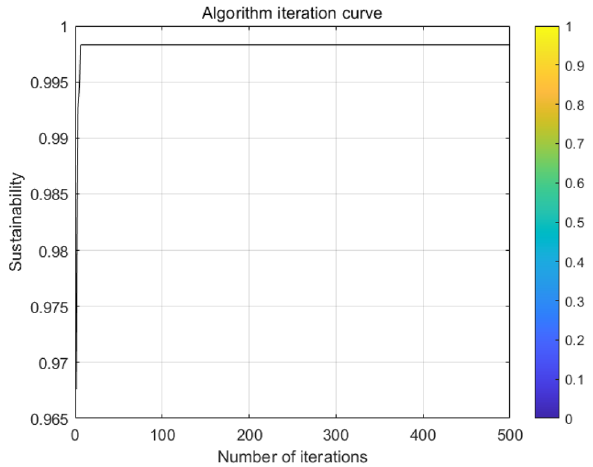
Figure 11. Sustainable iteration.